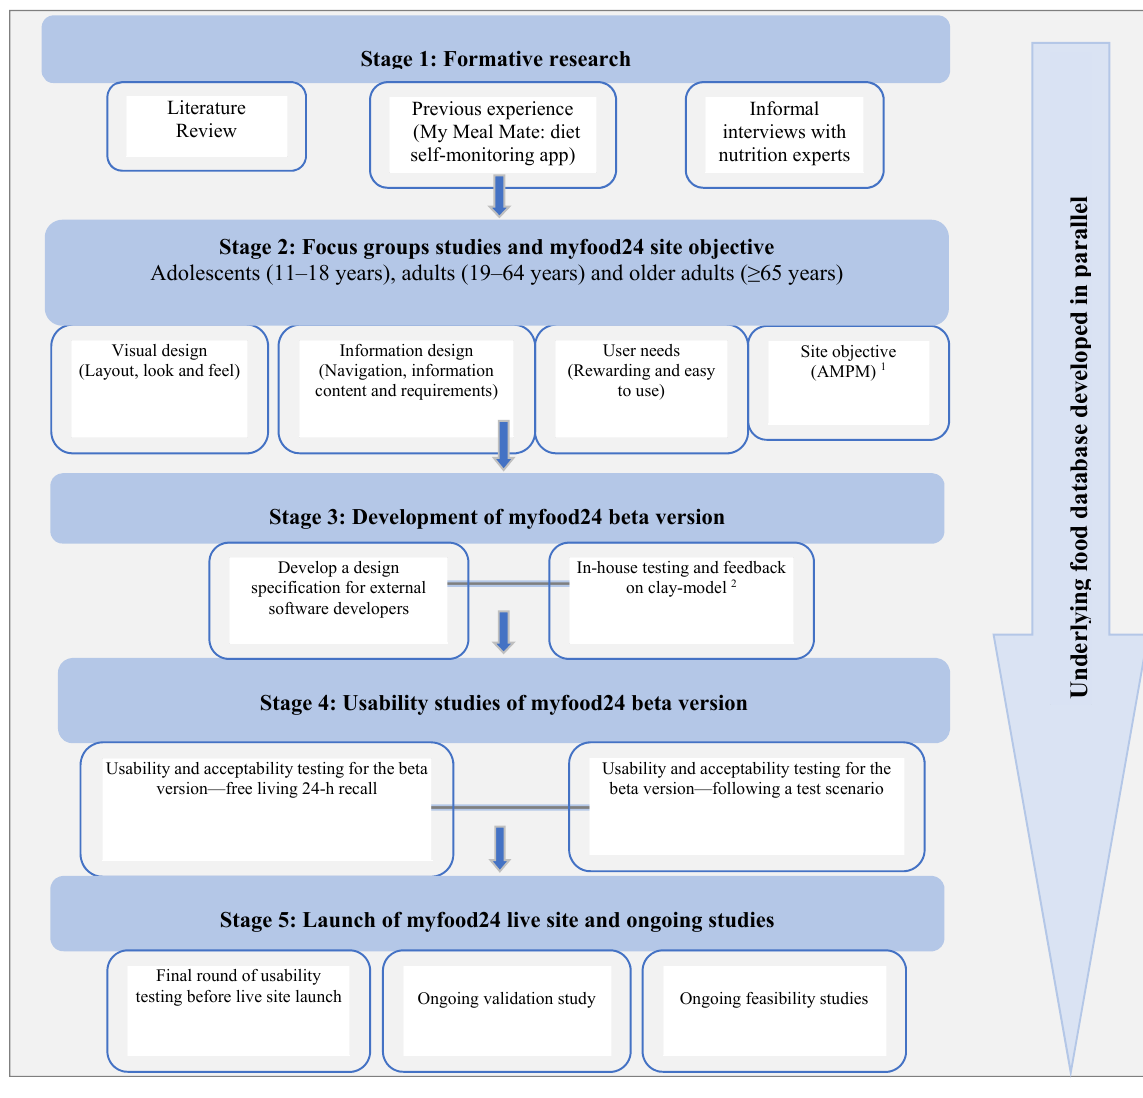
Figure 1. Flow chart illustrating the development process of myfood24. 1 AMPM = Automated Multiple-Pass Method; 2 “Clay model” = static clickable wire-frame without database